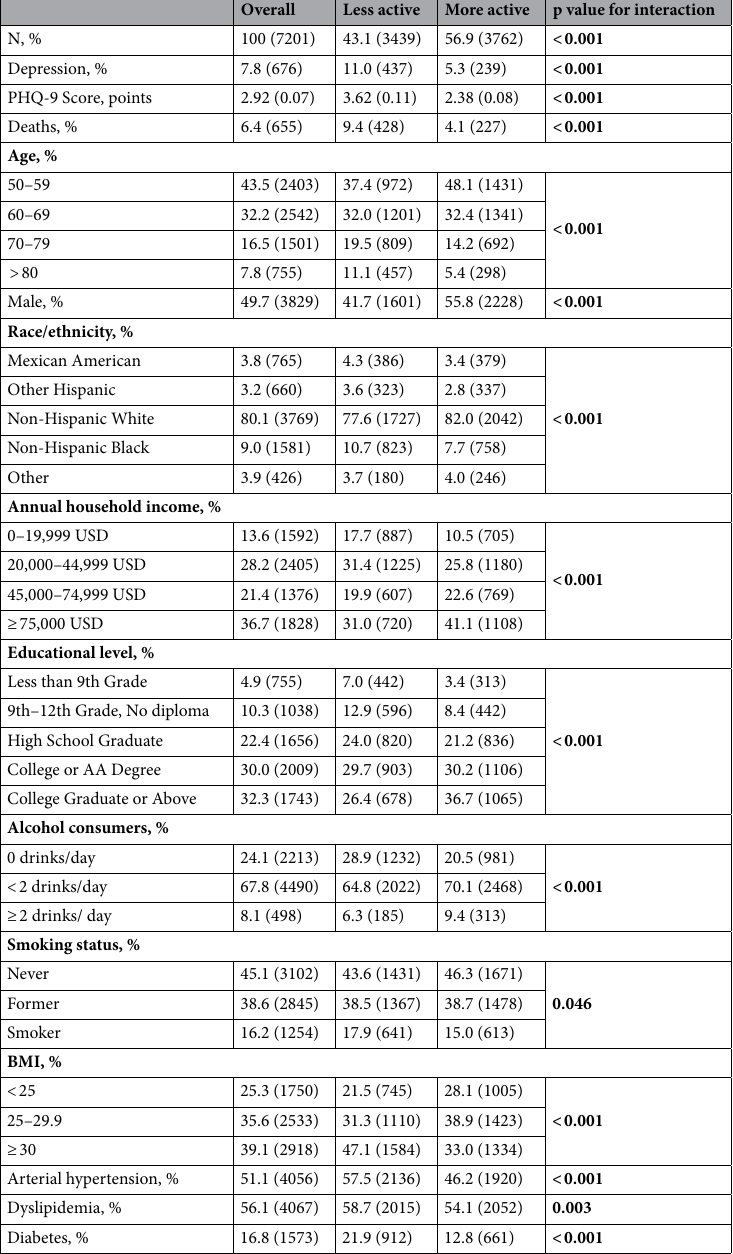
Table 1. Baseline characteristics of study participants according to level of physical activity. Data are expressed as weighted percentages and unweighted number of participants for categorical variables, and as weighted mean (standard error) for continuous variables. Less active: performed < 600 MET-min/week; More active: performed ≥ 600 MET-min/week; Other: other race, including Multi-Racial; AA degree: Associate’s degree. Significant values are in